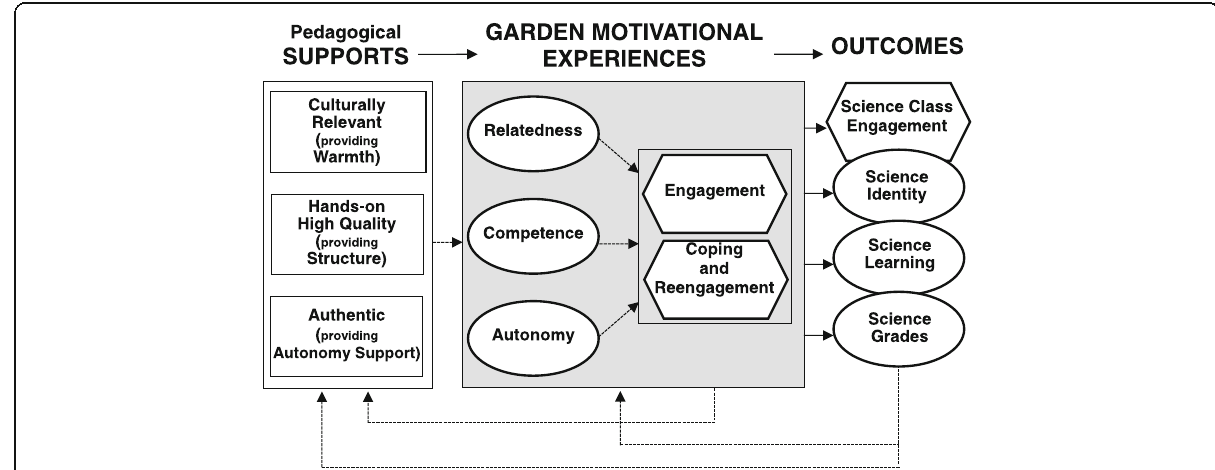
Fig. 2 A motivational model of science learning in the garden, in which culturally relevant and supportive pedagogical contexts foster high-quality motivational experiences in the garden (i.e., where students ’ needs for relatedness, competence, and autonomy are met and they are fully engaged in garden activities), which in turn promote students ’ engagement in science class as well as their science identity, learning, and grades. Solid lines indicate theoretical connections examined in the current study. (Adapted from Skinner et al.